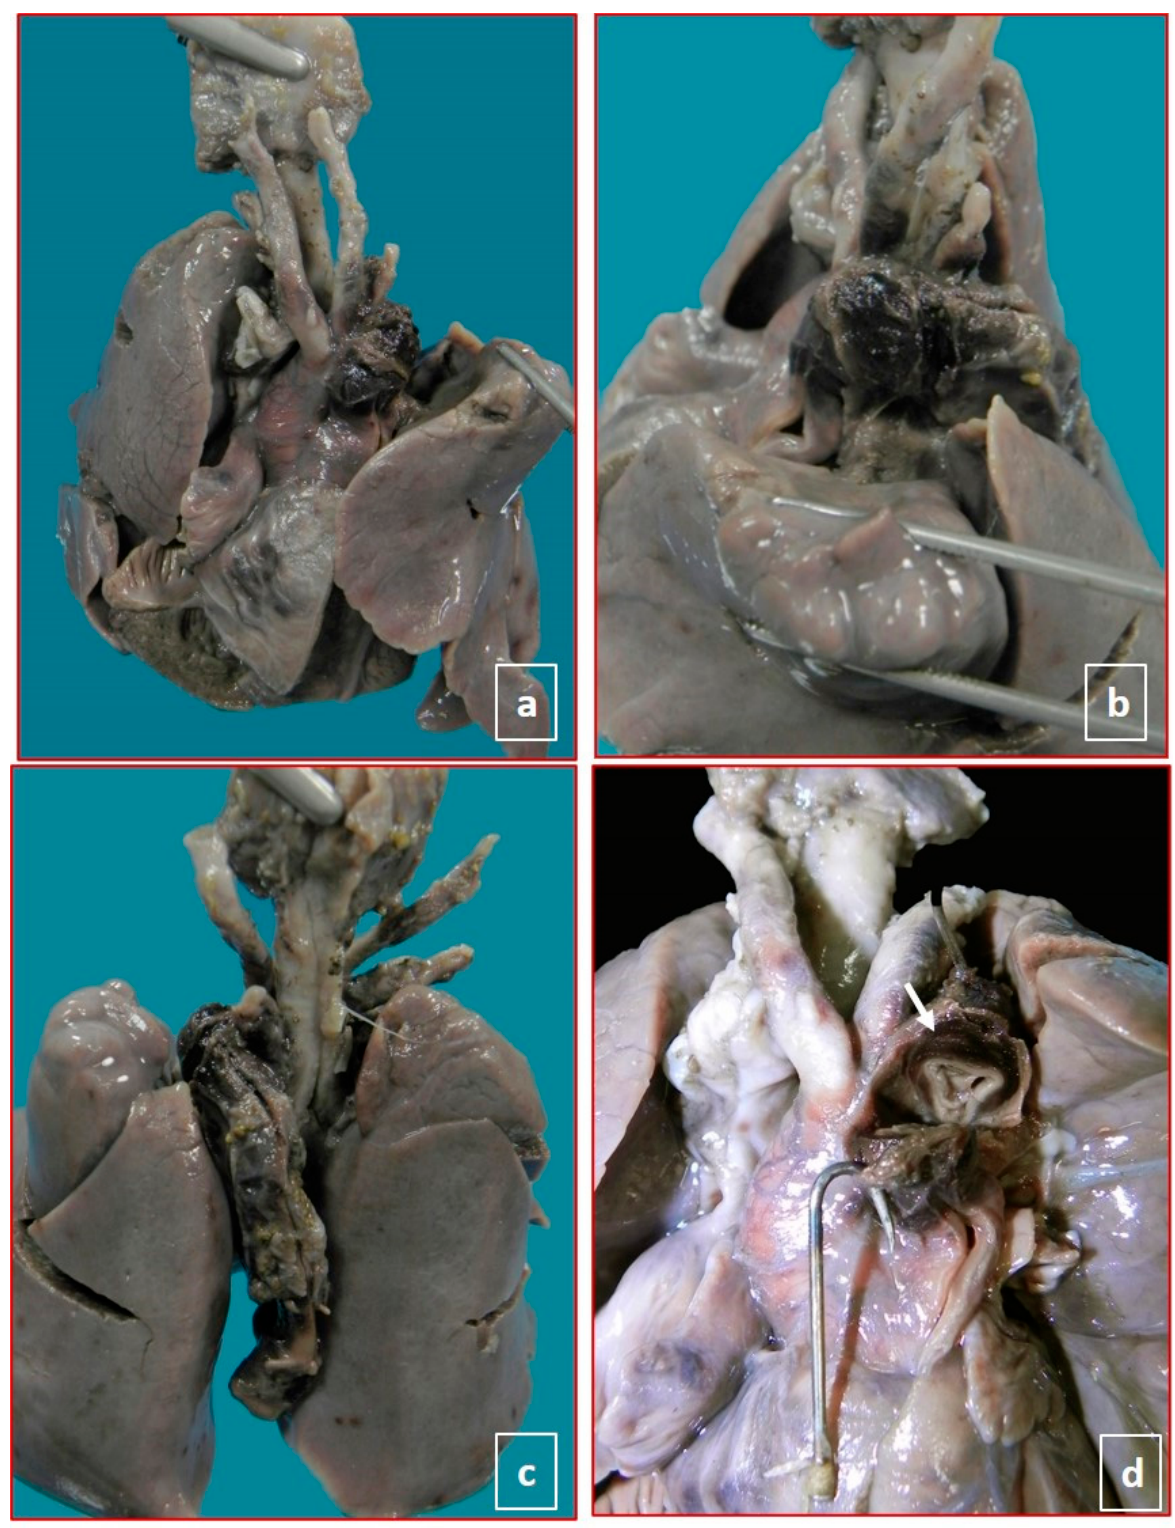
Figure 1. Male fetus, 32 gestation weeks (case 2), without congenital anomalies and slight intrauterine growth restriction. The placenta showed a fetal vascular malperfusion. No maternal pathology during this second pregnancy. ( a – c ), the localization and extension of peri-adventitial hematoma involving ductus arteriosus, aortic arch, brachiocephalic vessels, and descending aorta. ( d ), ab extrinseco compression of the aorta (white arrow).